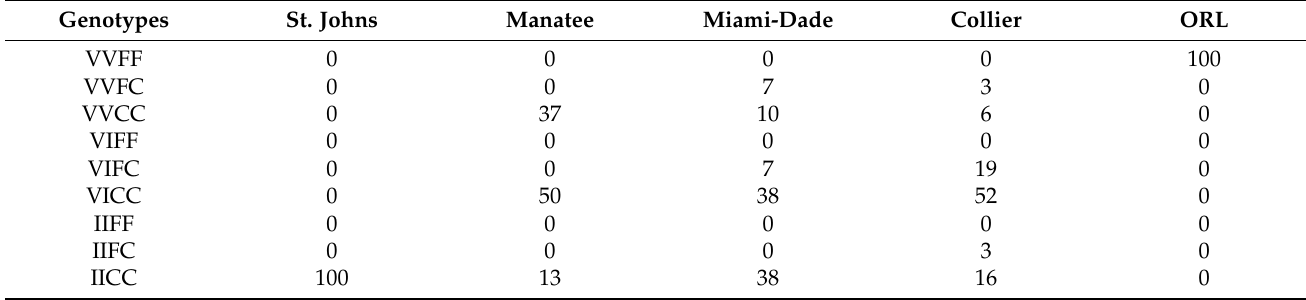
Table A4. Knockdown resistance ( kdr) genotype percentages for Florida Aedes aegypti field populations (St. Johns, Manatee, Miami- Dade, Collier) and a laboratory colony (Orlando;